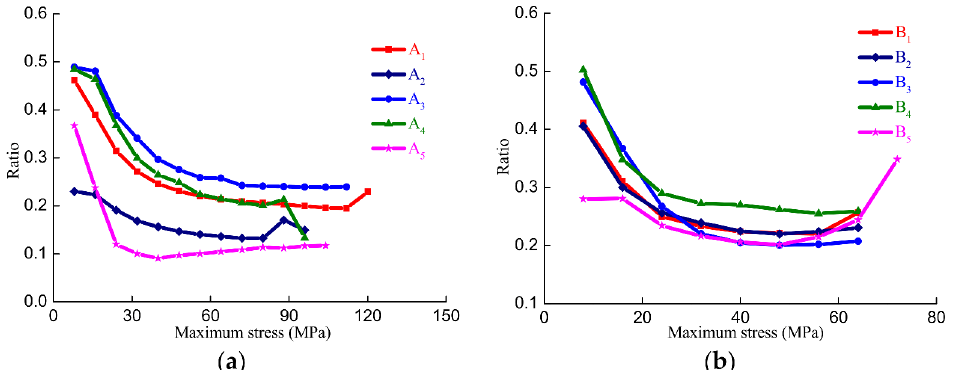
Figure 7. Dissipated strain energy ratio during cyclic loading and unloading of sandstone. ( a ) Dry rock samples. ( b ) Saturated rock